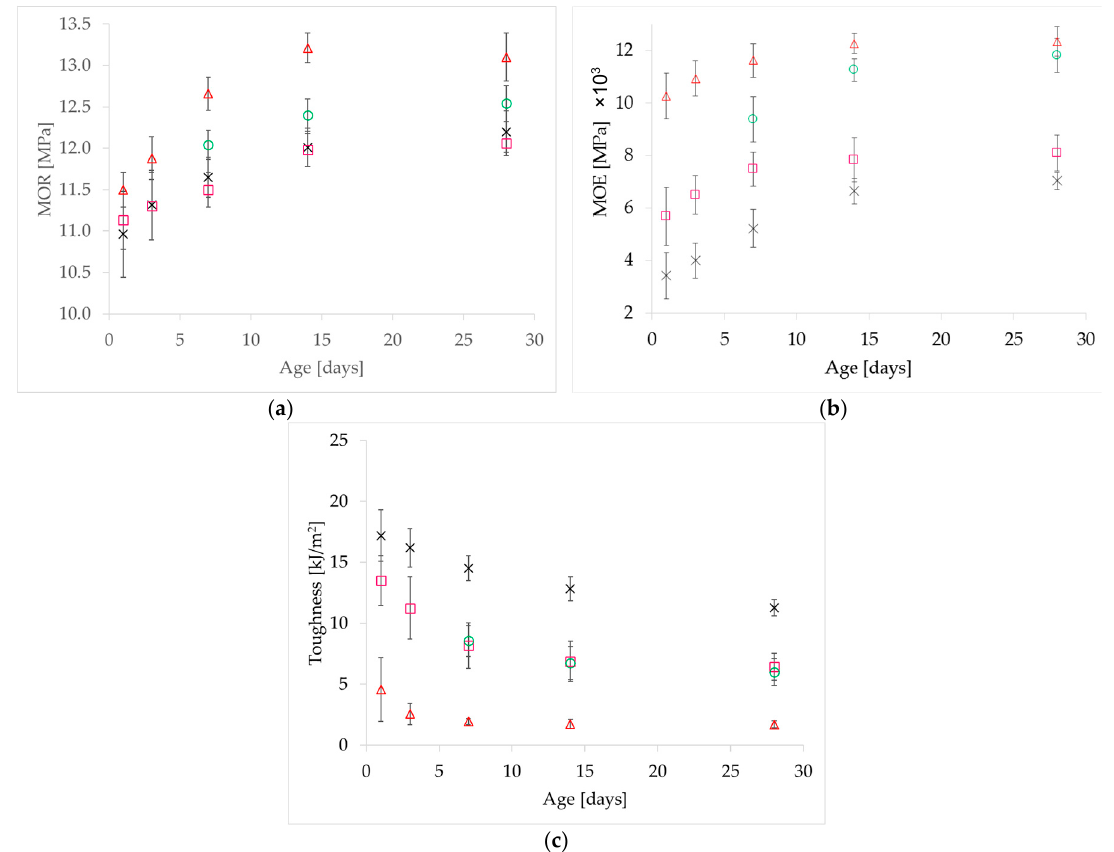
Figure 3. Average values of mechanical properties at different carbonation time ( × non-carbonated curing (NCC), □ 3 h accelerated carbonation curing (ACC), ● 5 h ACC and ∆ 9 h ACC): ( a ) Modulus of rupture (MOR); ( b ) modulus of elasticity (MOE) and ( c ) toughness.